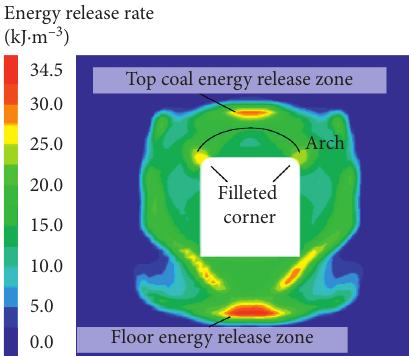
Figure 17: Nephogram of the local energy release rate of filleted corner